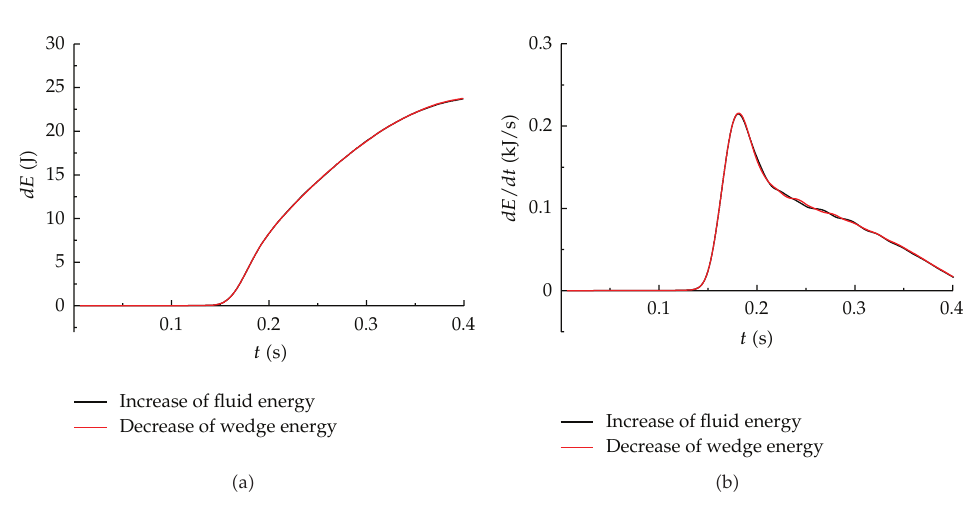
Figure 9: Comparison of value and its rate versus increase of fluid energy and decrease of wedge energy during the initial water-entry